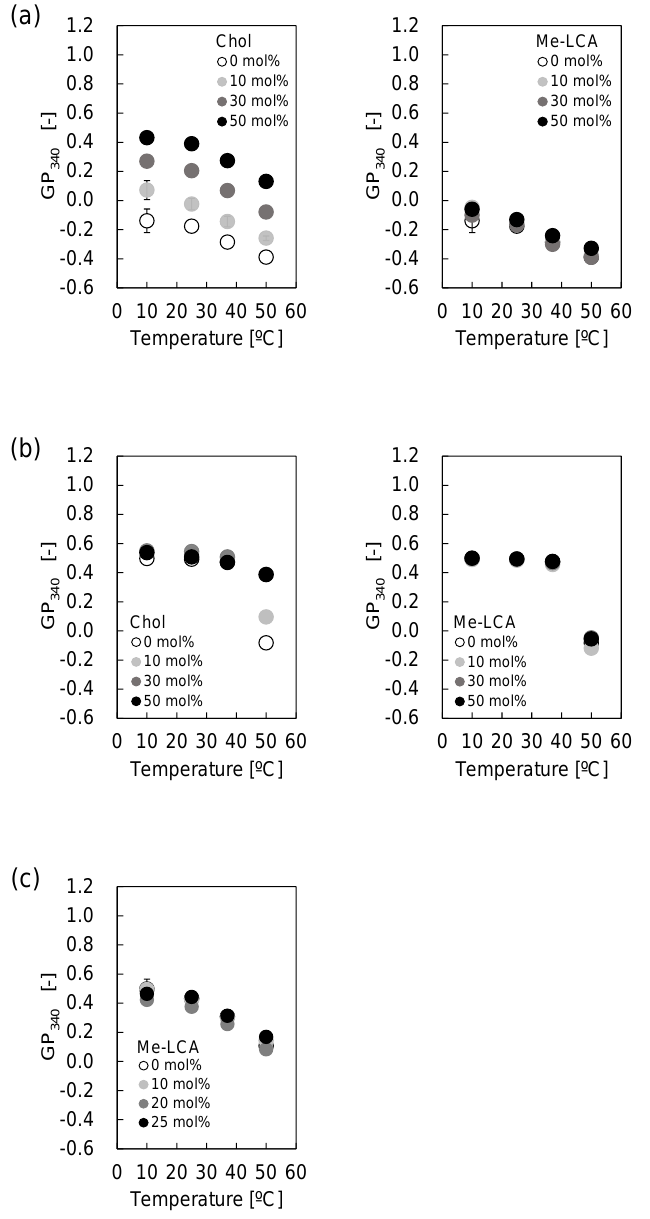
Figure 5. GP 340 values of ( a ) DOPC liposome, ( b ) DPPC liposome, and ( c ) DOPC/DPPC/Chol (1:1:1, mol/mol) liposome with Me-LCA.